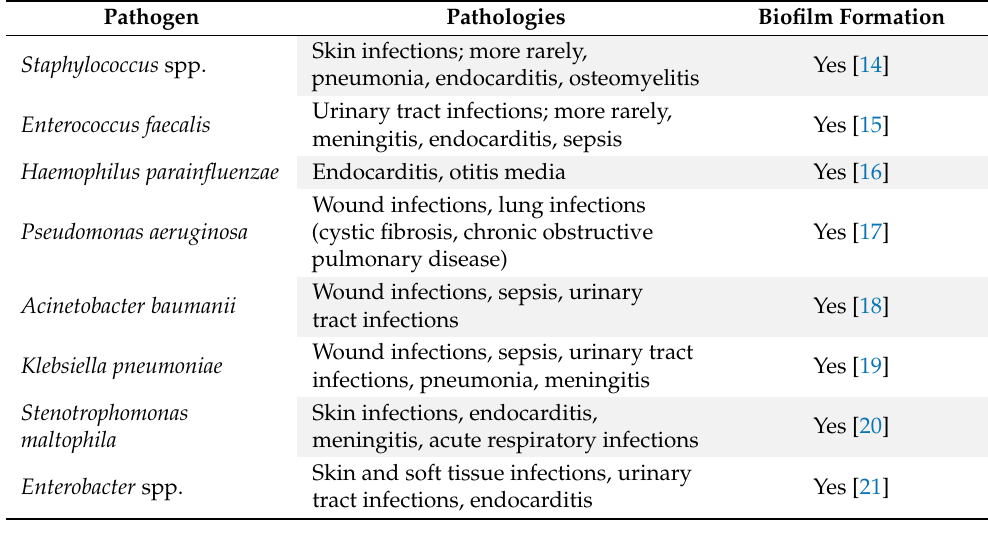
Table 1. Human Pathogens Identified by 16S rRNA Sequencing on Sentinel Washcloths after Laun- dering in Public Washing Machines.